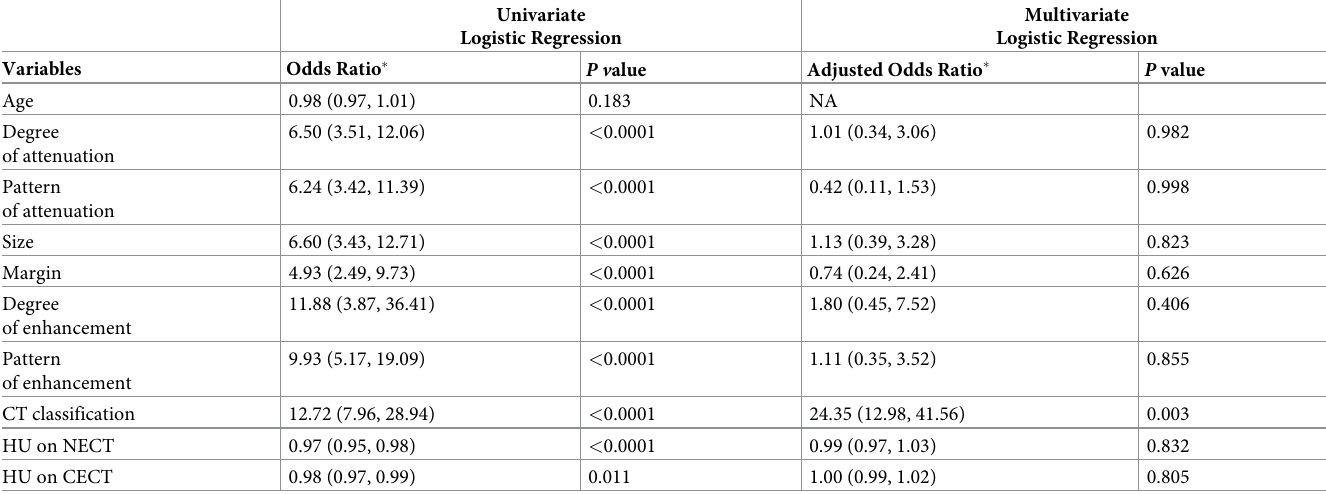
Table 3. Logistic regression analyses of the computed tomography findings for differentiating diffuse thyroid disease from normal thyroid parenchyma in 229